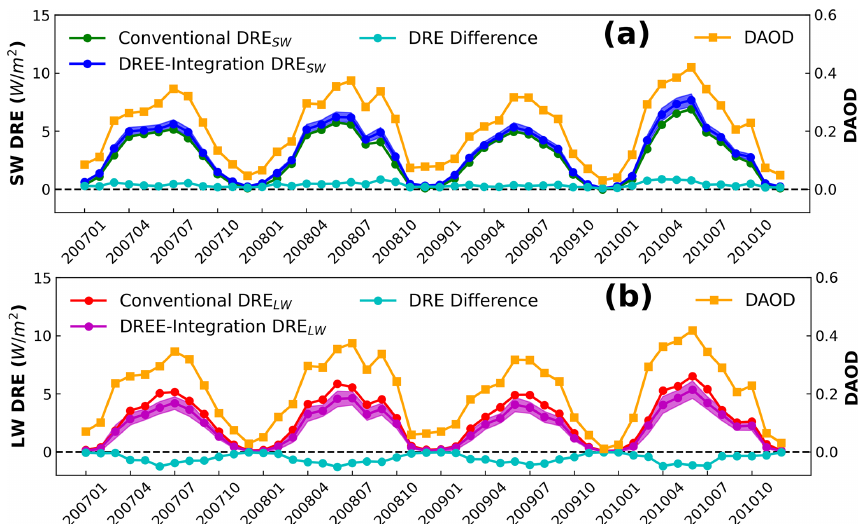
Figure 8. Monthly mean dust DRE SW (a) and DRE LW (b) comparison between conventional and DREE integration calculations from 2007 to 2010 over the Sahara Desert. The DRE difference line represents the difference between DREE integration and conventional calculations. Shaded areas along DREE integration DRE indicates the one standard deviation caused by the atmospheric and surface variations as well as dust vertical distribution variation within the 4 years. Orange curves indicate CALIOP-based monthly mean DAOD. The variation of dust DRE match well with DAOD variation.